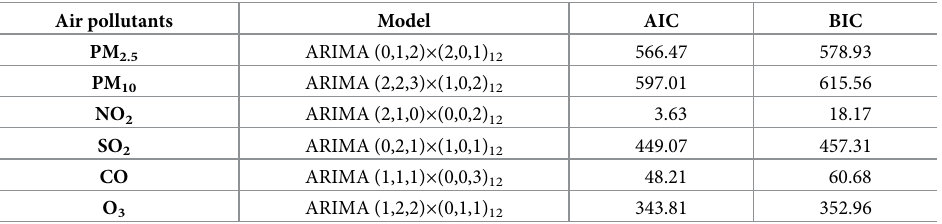
Table 5. The optimal models for each air